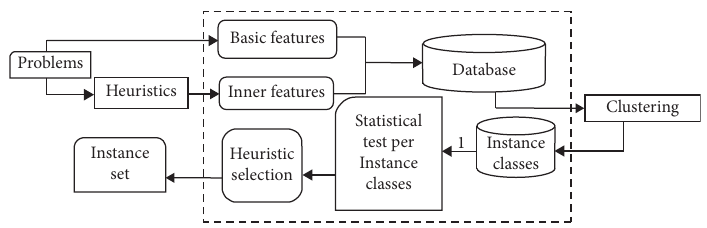
Figure 2: Metalearning process for the heuristics set